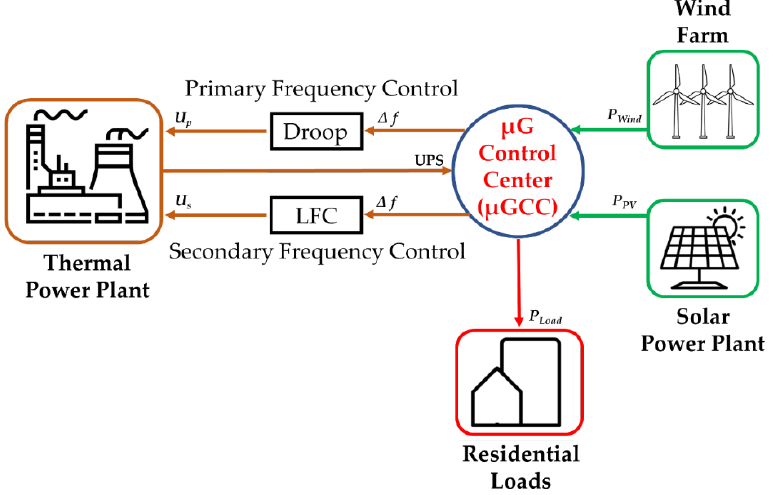
Figure 1. The layout diagram of the studied islanded µG.